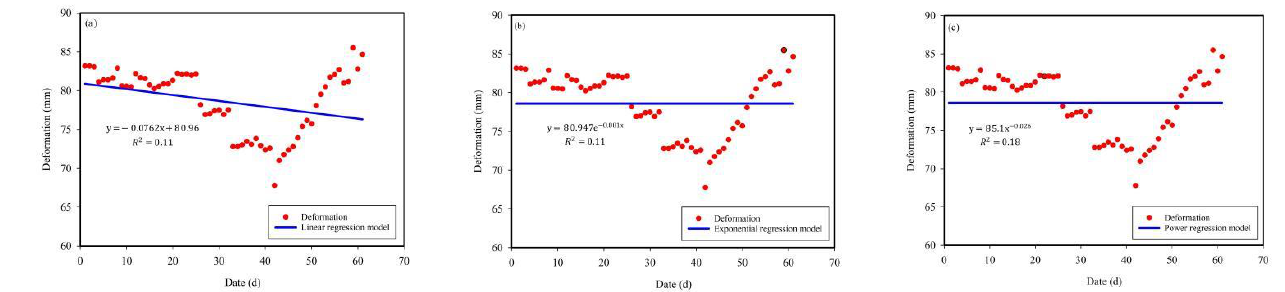
Figure 4. The results of regression analysis in the first threshold interval with different regression models. ( a ) Linear regression model; ( b ) exponential regression model; ( c ) power regression model. Figure 5. The results of regression analysis in the second threshold interval with different regression models. ( a ) Linear regression model; ( b ) exponential regression model; ( c ) power regression model.